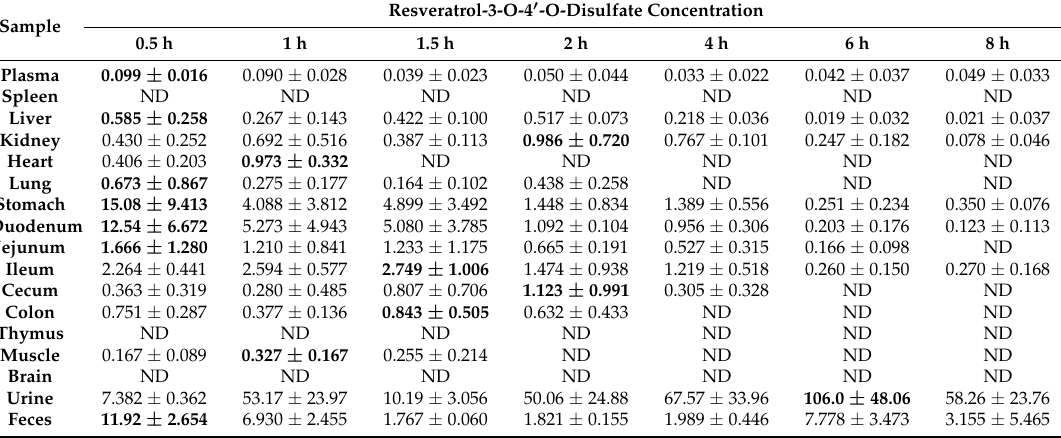
Table 4. Distribution of resveratrol-3-O-4 (cid:48) -O-disulfate in plasma (nmol/mL), various organs (nmol/g of tissue), urine (nmol/mL), and feces (nmol/g wet content) in mice at different time-points following the intragastric administration of resveratrol at a single dose of 10 mg/kg. Maximum concentrations (C max values) are in